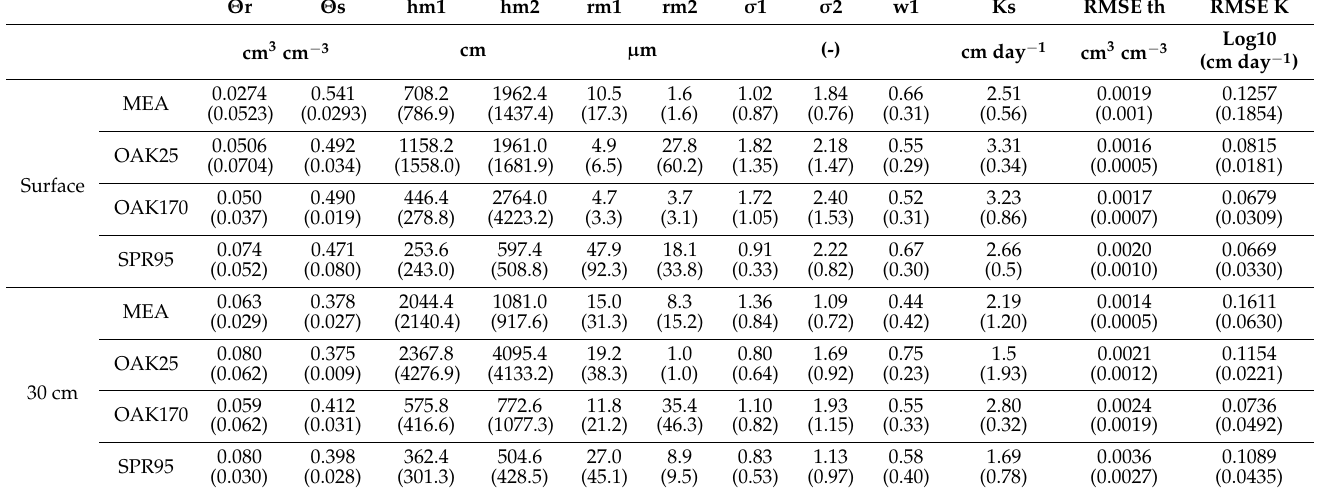
Table 2. Means of the water retention curve parameters fitted with the bimodal Kosugi model; residual ( θ r) and saturated ( θ s) water content, pressure heads at effective saturation Sei(hmi) = 0.5 for both the structural (hm1) and textural (hm2) domains, their respective standard deviations of the lognormal pore radii σ 1 and σ 2, and the weighting factor for the structural domain (w1). The weighting factor of textural domain (w2) can be obtained by 1-w1. Saturated hydraulic conductivity (KS) is presented as geometric mean of laboratory falling head measurements. Goodness of fit between observed and modeled values is expressed by the root mean square error (RMSE) for both the water retention and hydraulic conductivity characteristic. Standard deviation is presented in brackets.